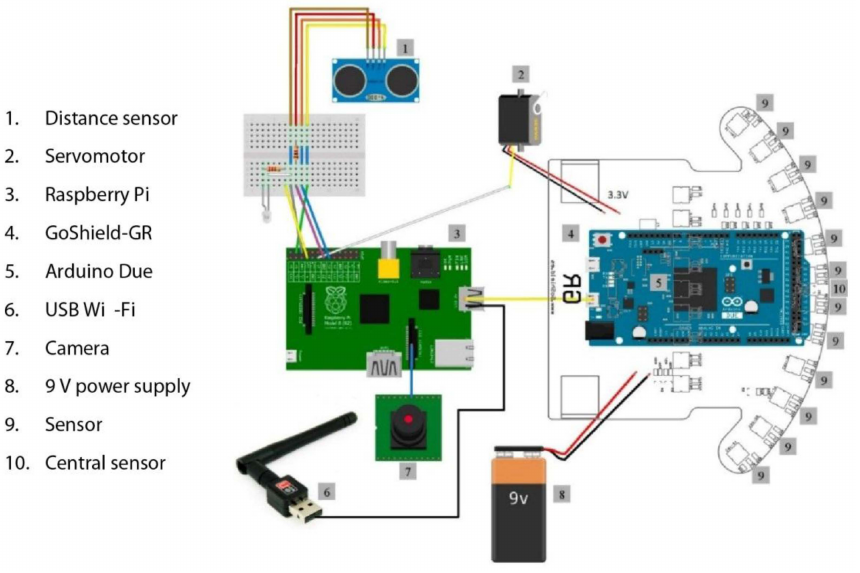
Figure 1. Robot design schematic.